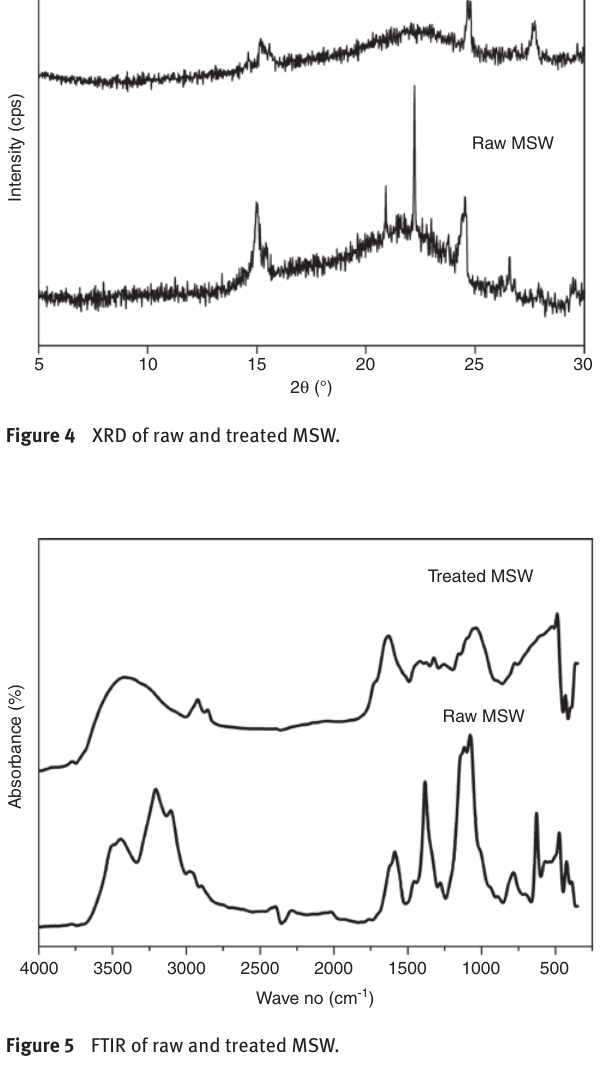
Figure 6. When the raw MSW is heated from room temper- ature to 100 ° C, there is a decrease in weight of the